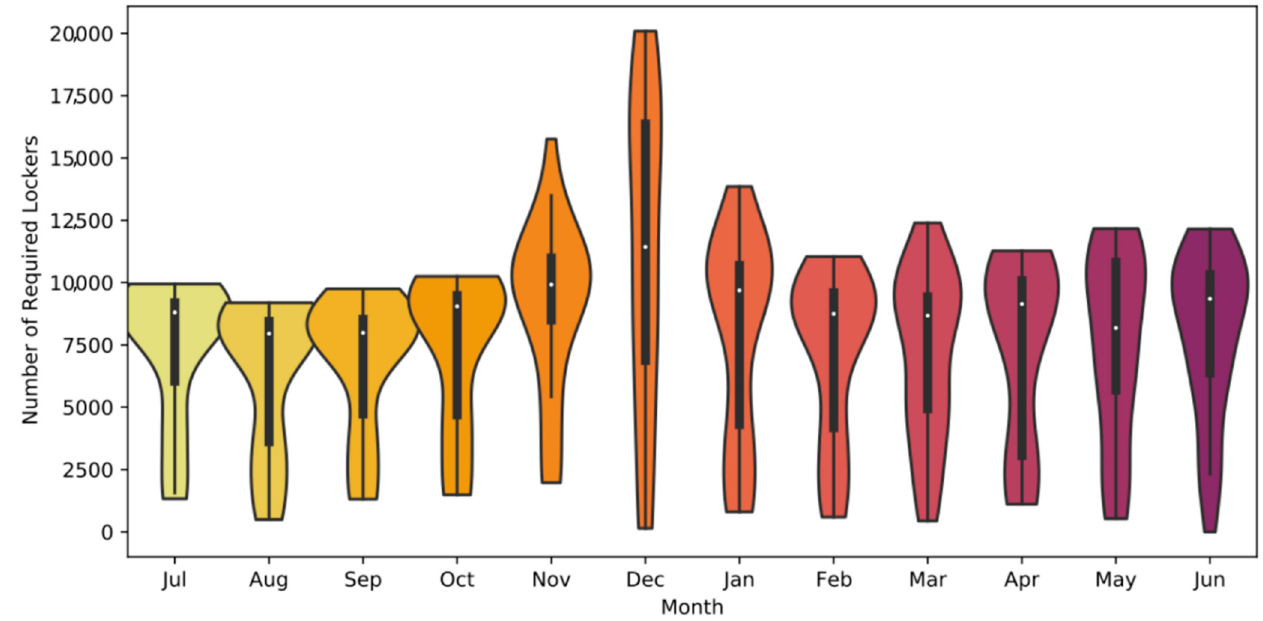
Figure 2. Number of lockers required per day depending on the month (Density 1.0).